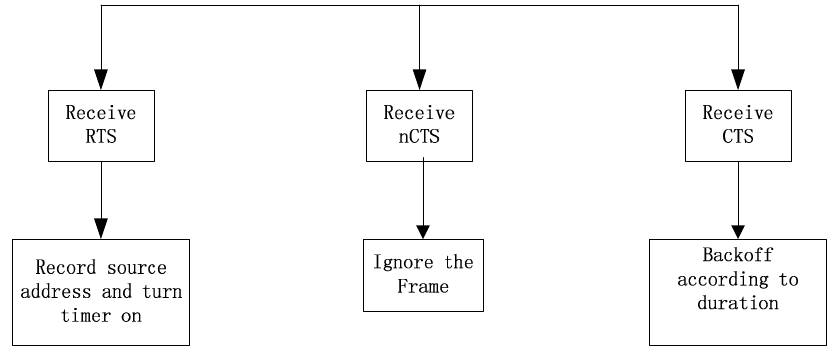
Figure 4. The processing flow of a node receiving a control frame that does not belong to itself when TET is off.